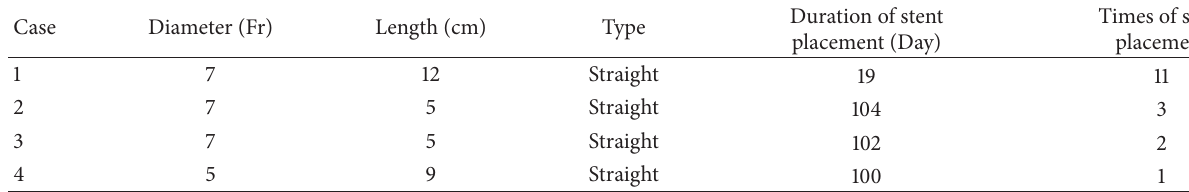
Table 9: Stents characteristics of fractured cases.